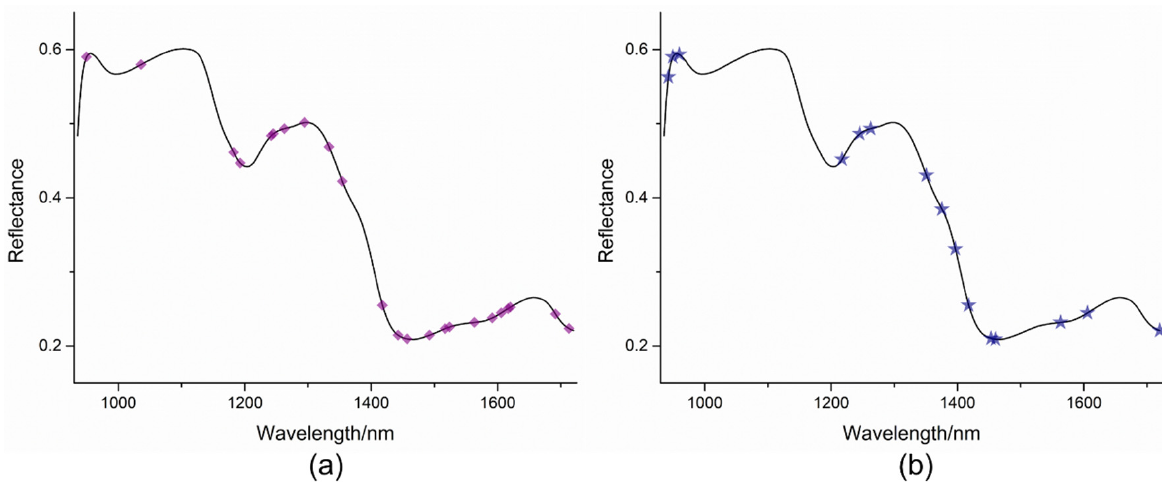
Figure 5. Distribution of the feature bands selected by GA ( a ) and SPA ( b ). Table 2. Performance of BPNN models established by feature bands.